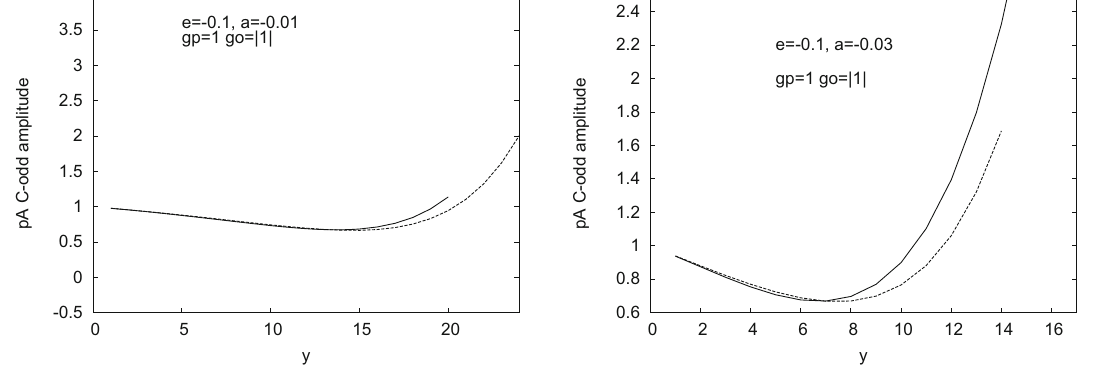
become visible at rapidities probably outside the region of convergence, which is observed at y > 5 for λ = 0 .